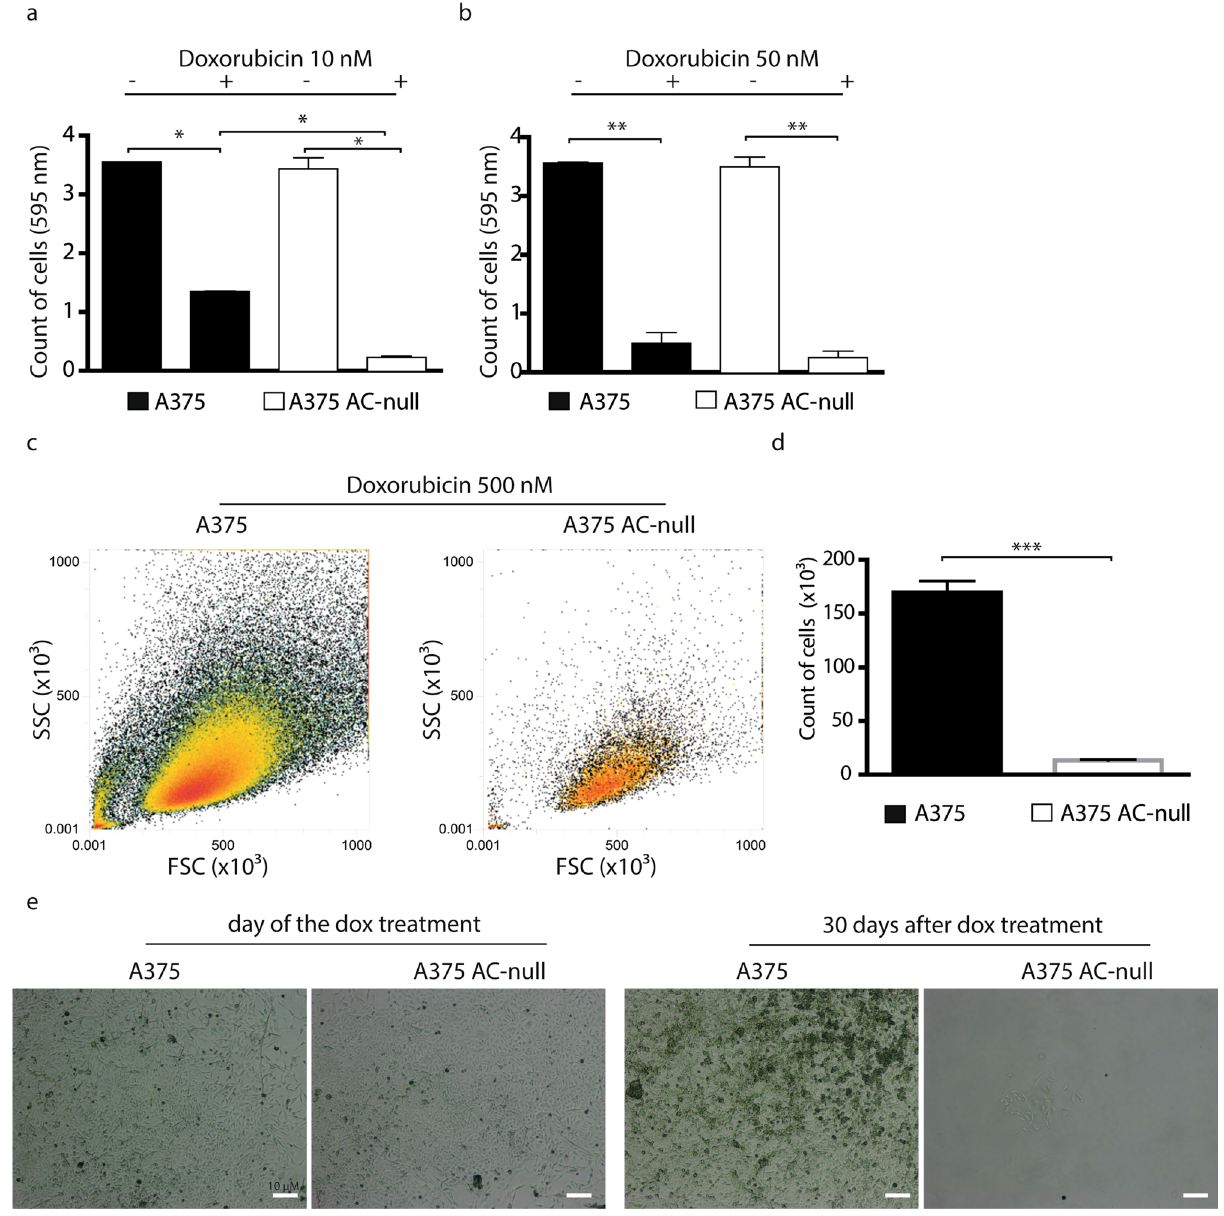
Figure 3. Long-term recovery assay after doxorubicin treatment of A375 and A375 AC-null cells. ( a ) crystal violet colorimetric detection of total cells 8 days after 10 nM doxorubicin administration, data are expressed as mean ± SD, the statistical analysis was performed using Student’s t test (* p < 0.05, ** p < 0.01, *** p < 0.001). ( b ) crystal violet colorimetric detection of total cells 8 days after 50 nM doxorubicin administration, data are expressed as mean ± SD. ( c ) Total number of A375 and A375 AC-null cells detection 30 days after 500 nM doxorubicin treatment using flow cytometry assay. ( d ) Statistical analysis of cells detected in ( c ), data are expressed as mean ± SD, the statistical analysis was performed using Student’s t test (* p < 0.05, ** p < 0.01, *** p < 0.001). ( e ) A375 and A375 AC-null cells images taken by optical microscope before and after the doxorubicin treatment described in ( c